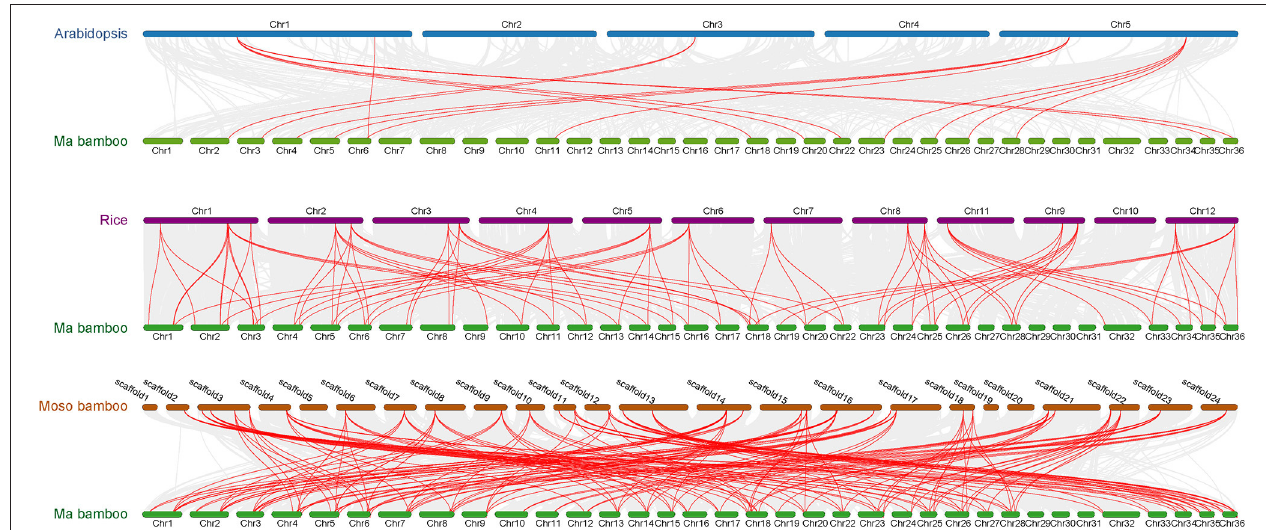
FIGURE 4 | Collinear relationships of genes pairs from Ma bamboo, Moso bamboo, rice, and Arabidopsis . Gray lines indicate that all the collinear gene pairs between Ma bamboo and other species, whereas red lines indicate the collinear TCP gene